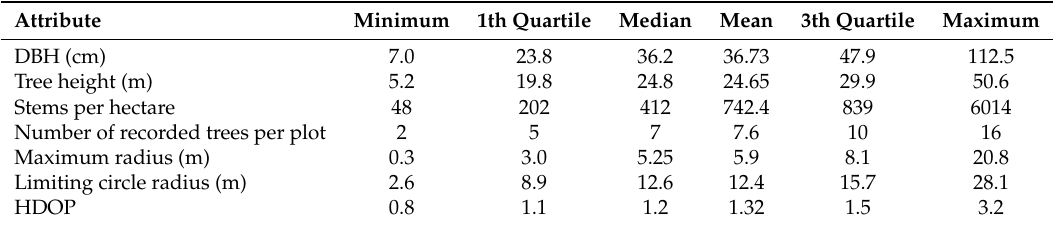
Table 1. Basic statistics of the 133 investigated BWI plots. DBH: diameter at breast height; HDOP: horizontal dilution of